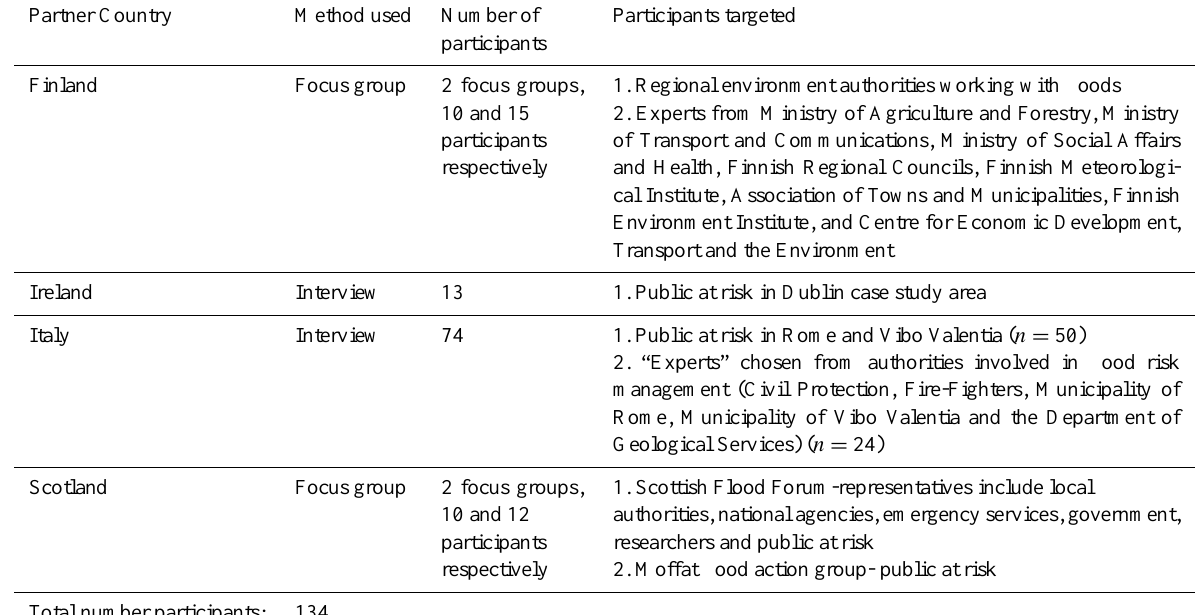
Table 3. Qualitative data collection in the partner